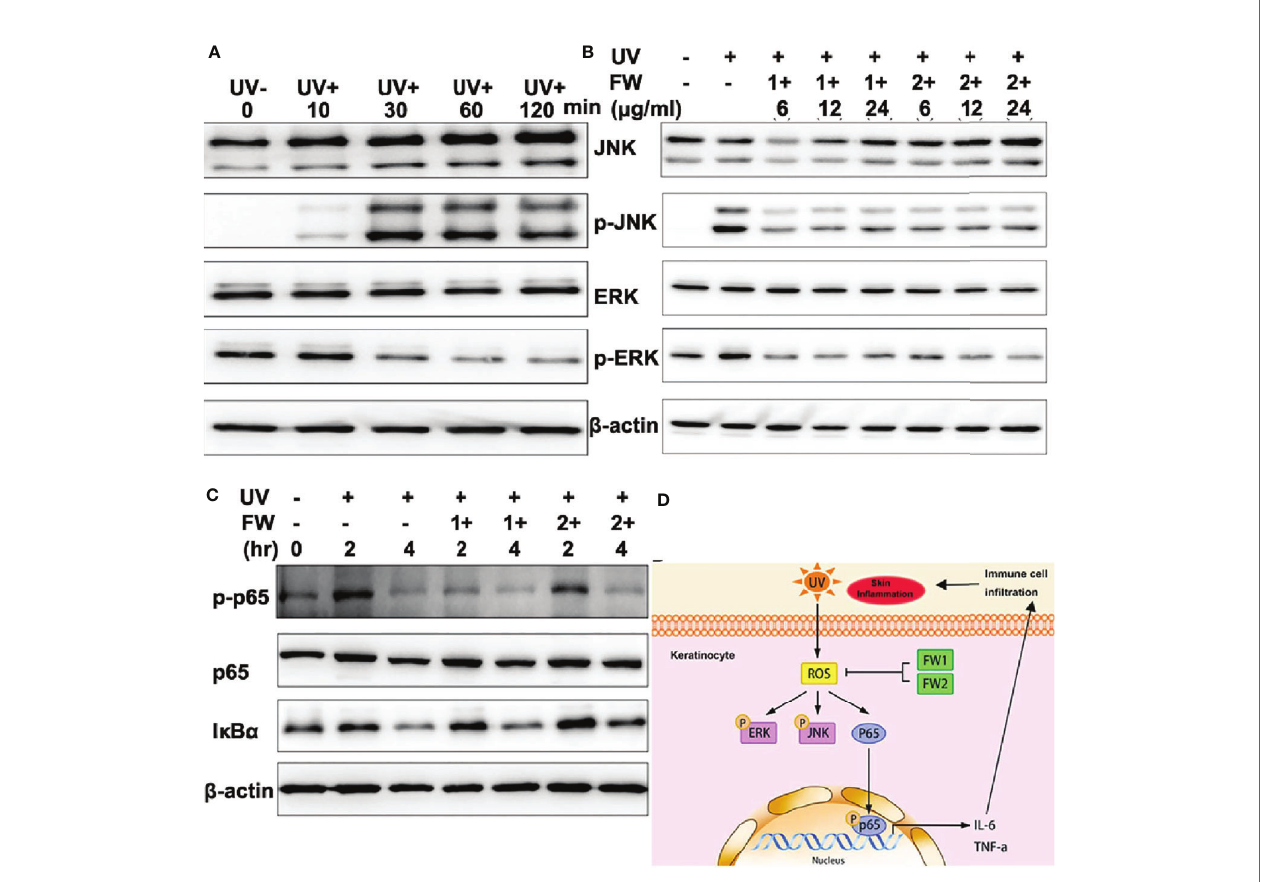
FIGURE 6 | FW-1 and -2 suppress UV-induced stress signaling in keratinocytes. (A) HaCaT cells were exposed to UVB radiation (10 mJ/cm 2 ) and incubated for the indicated times. The cell lysates were then immunoblotted with the indicated antibodies. (B) HaCaT cells treated with FW-1 and -2 at different doses relevant to our studies were exposed to UV irradiation (10 mJ/cm 2 ). After 4 hr, the extracted proteins were then immunoblotted with the indicated antibodies. (C) HaCaT cells with or without FW-1 and -2 treatment were exposed to UVB radiation (10 mJ/cm 2 ) and incubated for the indicated times. The cell lysates were then immunoblotted with the indicated antibodies. (D) Schematic representation of frog skin derived peptides FW-1 and -2 act as modulator in UV-induced in fl ammatory